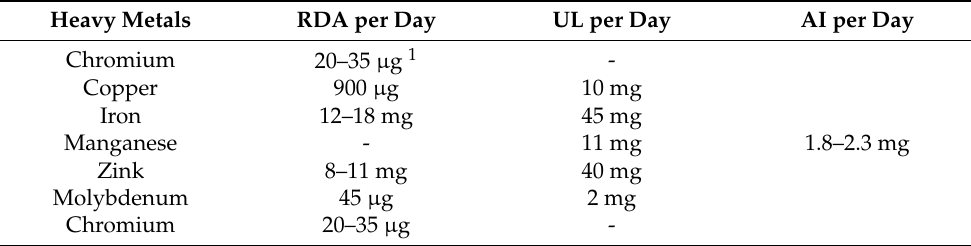
Table 7. The dietary reference intake of the heavy